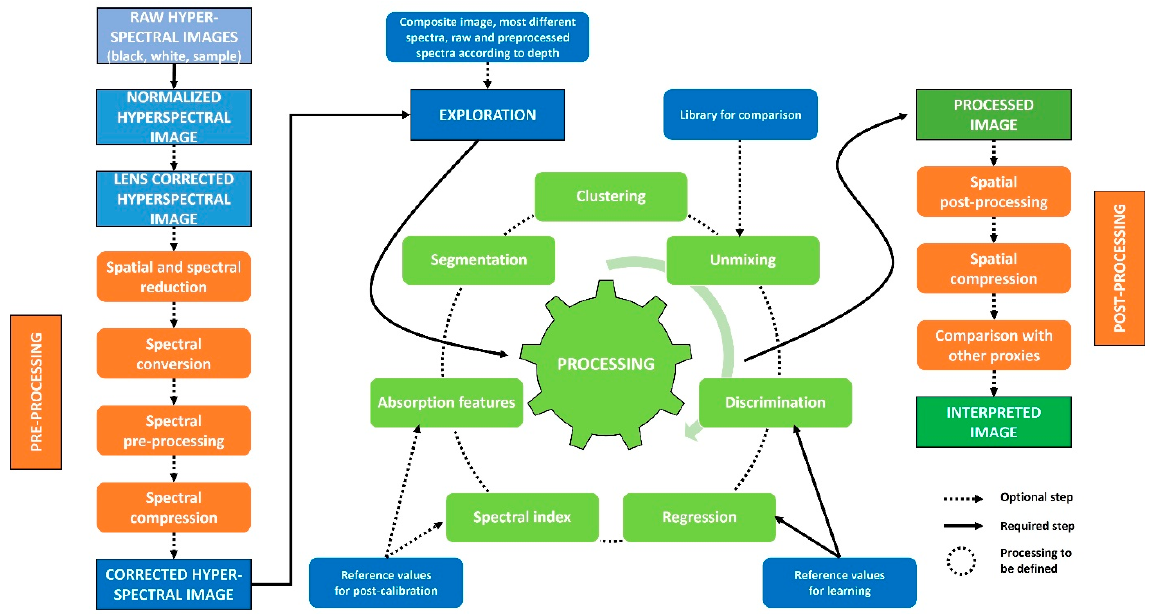
Figure 8. Diagram of the different steps that can be performed to (1) correct the initial HSI (prepro- cessing), (2) visualize the information contained in the image (exploration), (3) extract the information of interest (processing), and (4) apply a final correction (postprocessing) leading to a properly interpreted image.